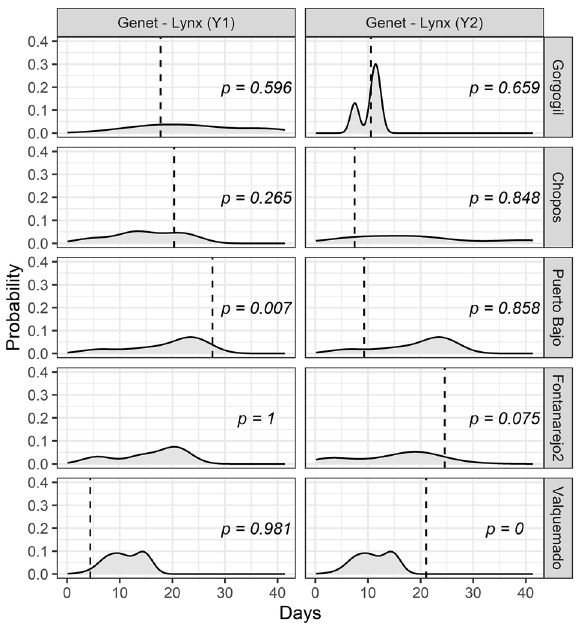
Figure 5. Spatio-temporal segregation patterns of common genets respect to the Iberian lynx in each locality and year. The vertical dashed lines represent the observed median minimum time-to-encounter between a lynx and a genet and the shaded grey area shows randomly simulated times-to-encounter. The p-values represents the proportion of randomly generated times-to-encounter values that are greater than the observed time-to-